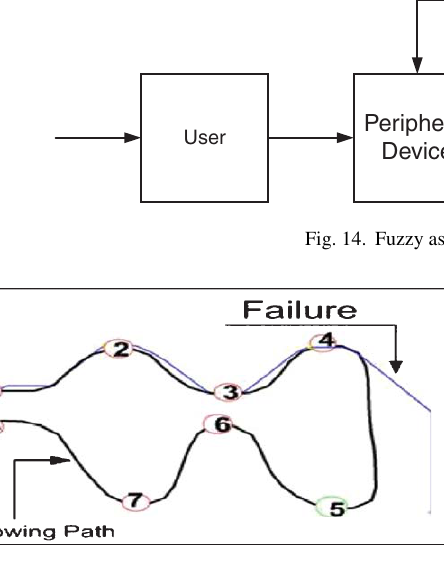
Fig. 15. Trajectory of impaired patient.